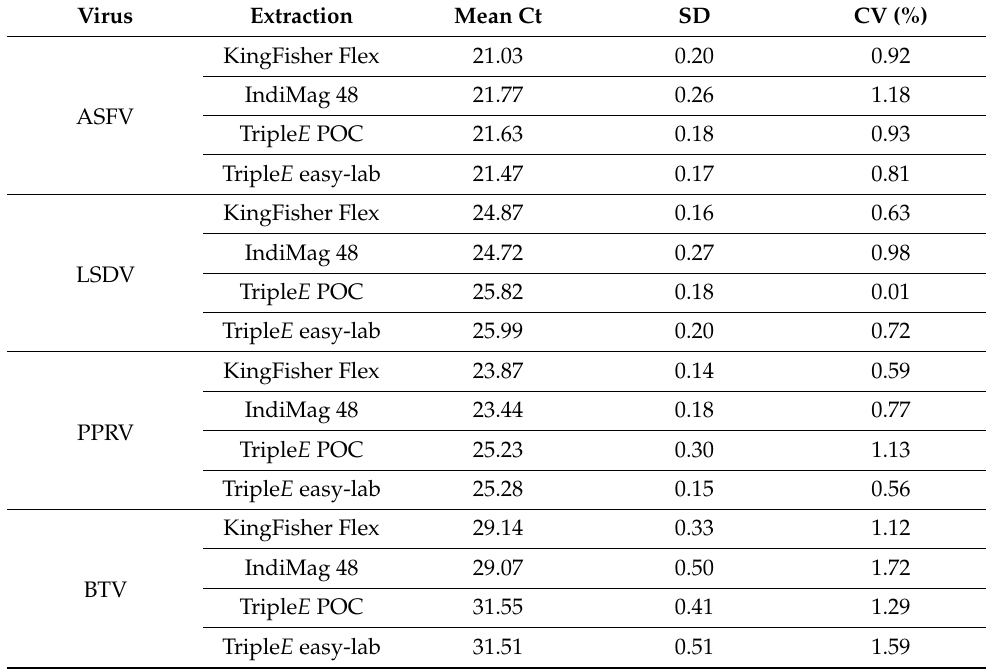
Table 2. Reproducibility of the standard protocol compared with four extraction protocols. Intra-run